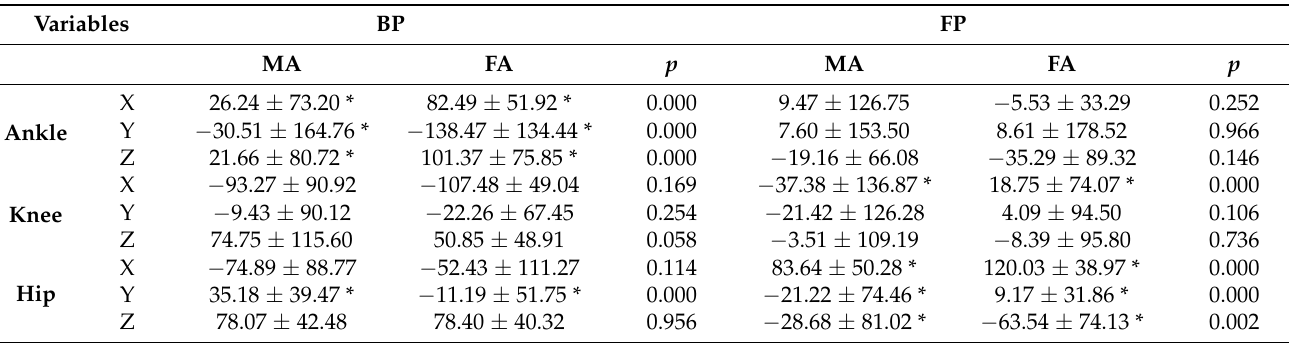
Table 5. Comparison of means ± standard deviations for the joint velocity values in the BP and FP between MA and FA (unit: degrees/second).